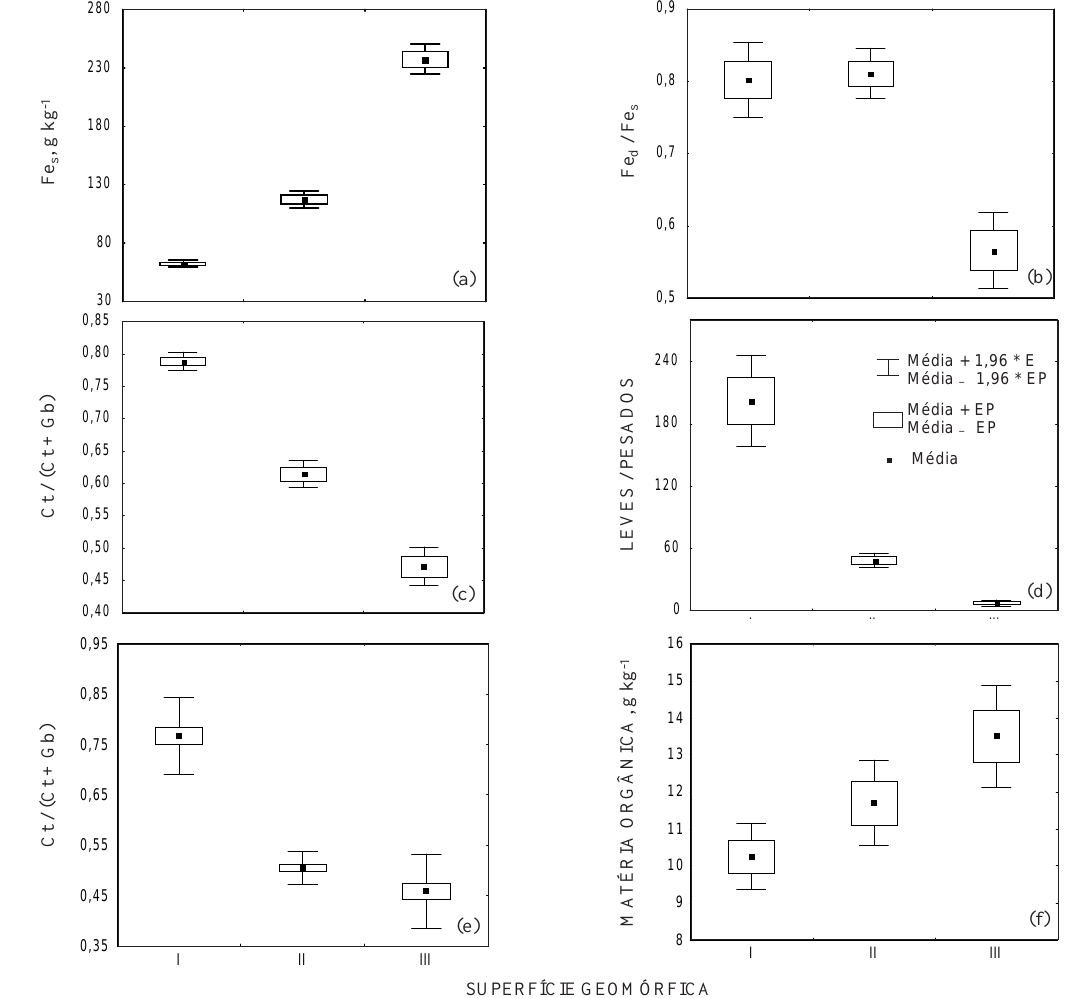
Figura 3. Médias, com respectivos intervalos de confiança, de atributos químicos e mineralógicos dos solos (profundidade de 0,6 a 0,8 m), de acordo com as respectivas superfícies geomórficas: (a) Fe (c) Ct/(Ct + Gb); (d) razão minerais leves/pesados; (e) Ct/(Ct + Gb) dos dados laterais; (f) matéria orgânica.